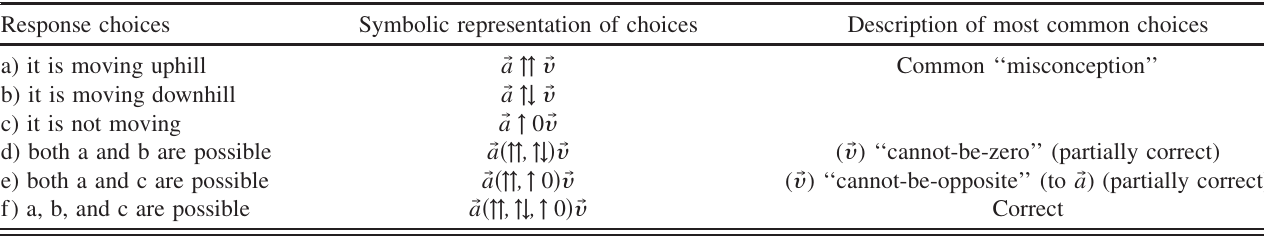
TABLE III. Available student response choices for each question. Almost all possible choices for the relationship between two vectors are available responses for a student to choose from when answering a question. The other possible choices were almost never chosen, thus excluded. Consider the ~a ! ~v question as an example: ‘‘A car is on a hill and the direction of its acceleration is uphill. Which statement best describes the motion of the car at this time?’’